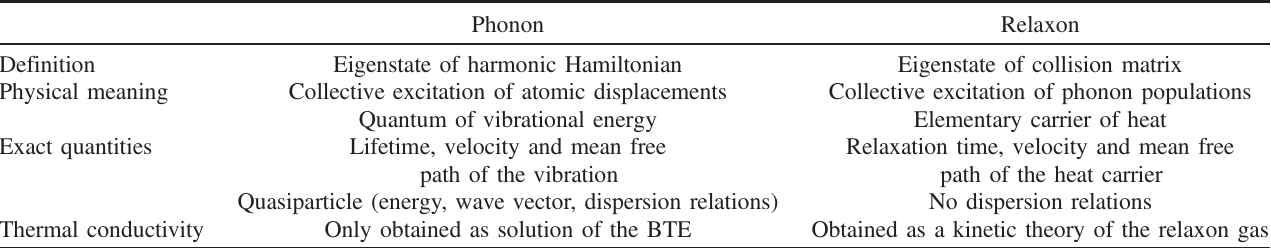
TABLE I. A comparison of the main properties of phonons and